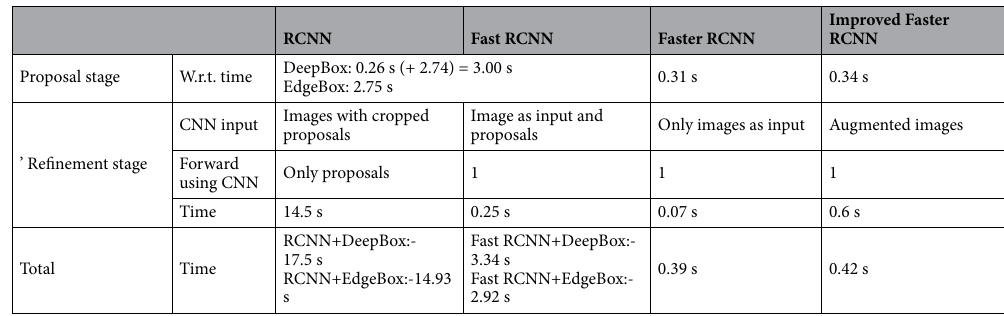
Table 3. Comparison of the proposed Faster RCNN with other region-based modules.